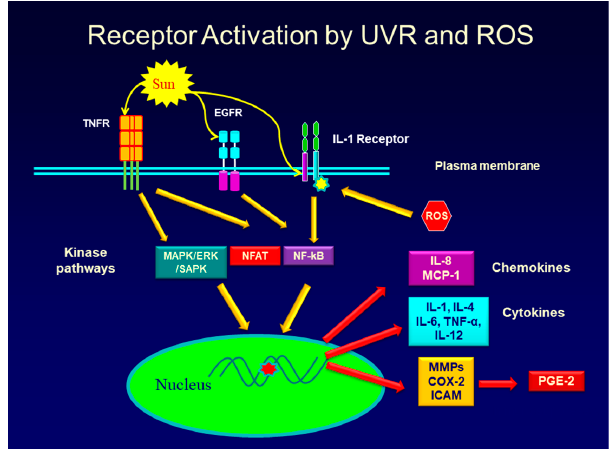
Figure 1. Activation of three signaling pathways in keratinocytes by UVR (ultraviolet radiation) and ROS (reactive oxygen species). UVR can activate surface receptors either directly, or indirectly by increasing the level of ROS, which then leads to receptor activation.